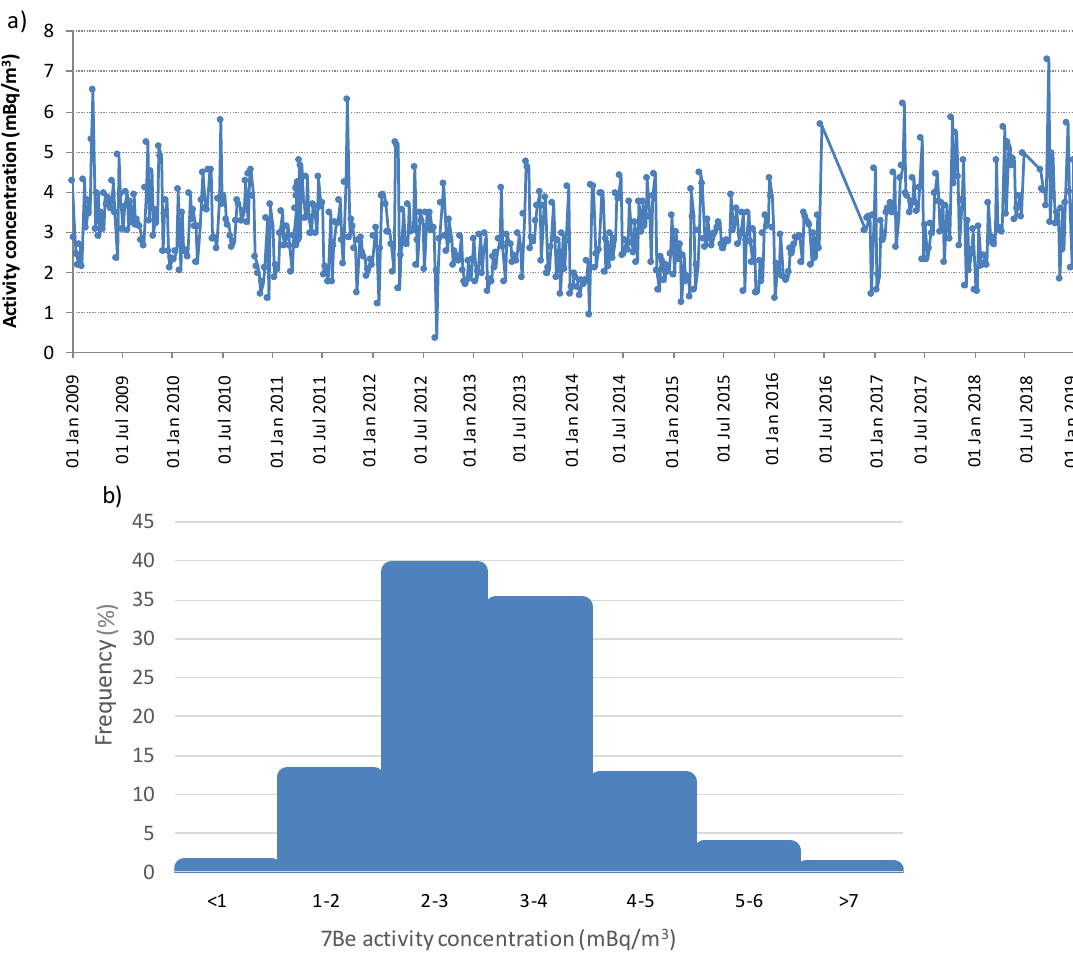
Figure 3. ( a ) Temporal variation and ( b ) histogram of the 7 Be activity concentrations from January 2009 to December 2018 at Bilbao sampling station.